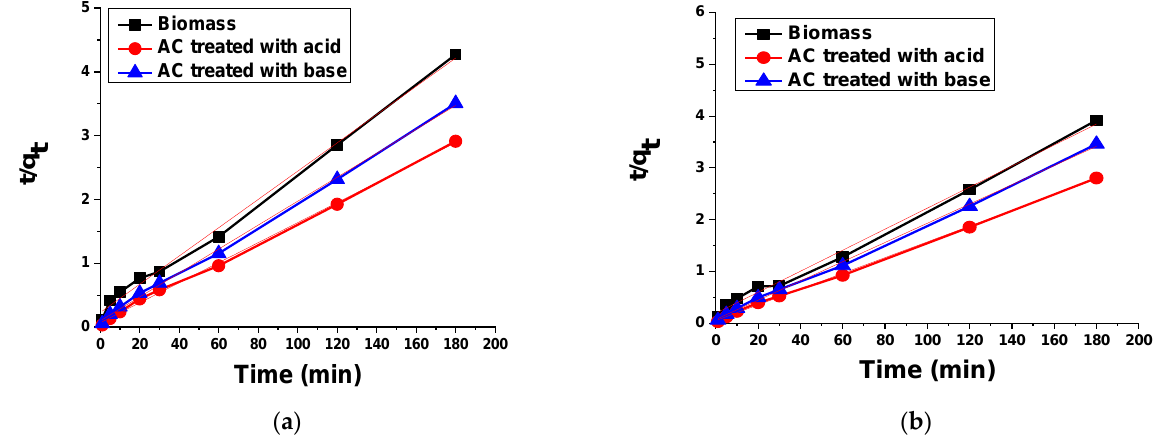
Figure 10. Pseudo-second order kinetic plot for the adsorption of ( a ) TB and ( b ) XO on biomass and AC treated with acid and base.